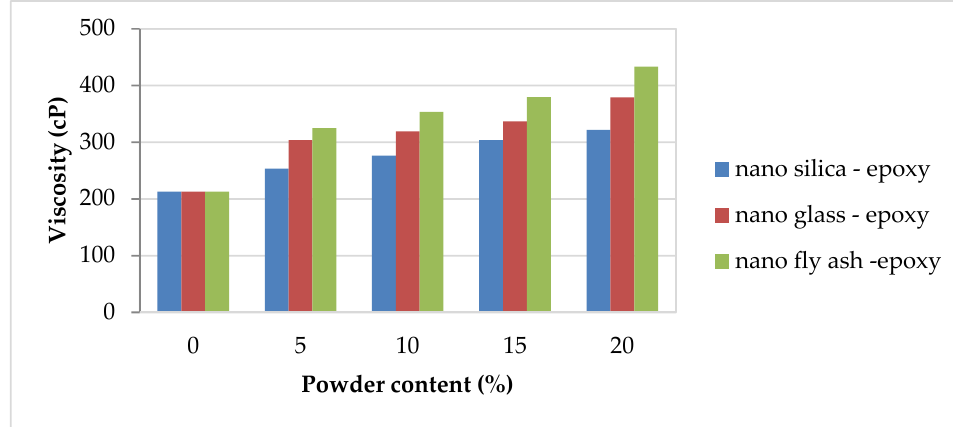
Figure 3. Viscosity magnitudes of the nanopowder-filled epoxy.